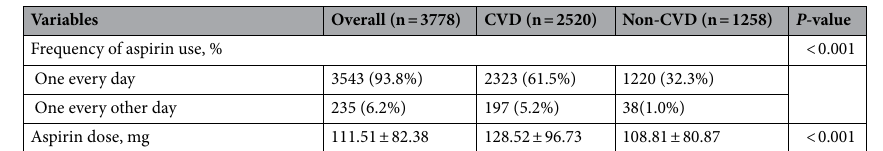
Table 1. Demographic characteristics of the study participants. Data are presented as mean ± SD or n (%). CVD cardiovascular disease, DM diabetes mellitus, PA physical activity, BMI body mass index, Hb hemoglobin, Scr serum creatinine, BUN blood urea nitrogen, UA uric acid, TC total cholesterol, TG triglycerides, HDL- cholesterol high density lipoprotein-cholesterol.